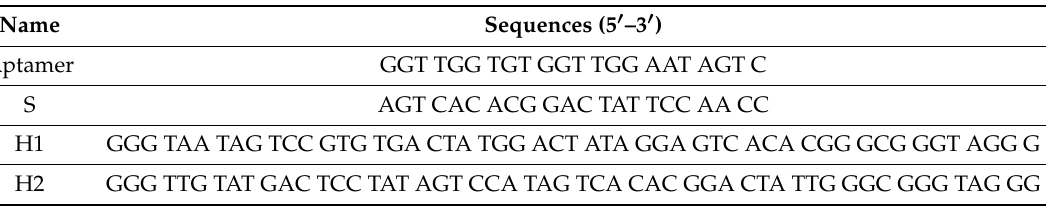
Table 1. Sequences of